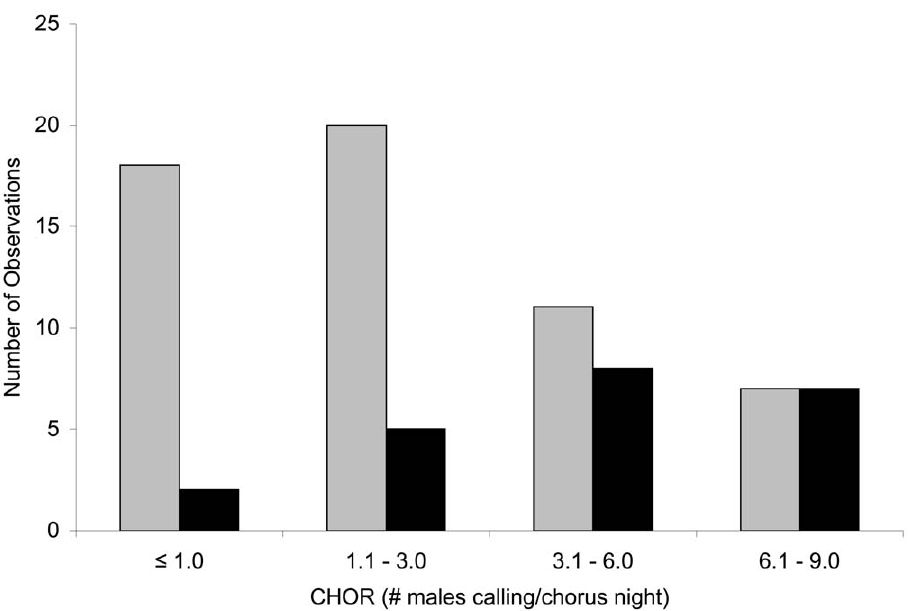
Figure 1. Frequency of observation and reproductive success of four chorus size classes. Mean number of Houston toad ( Bufo houstonensis ) males attending choruses calculated from nights on which at least one male was heard calling (CHOR, grey bars) and number of ponds exhibiting evidence of reproduction (black bars) for four chorus size classes. Proportion of ponds with evidence of reproduction goes up as CHOR increases, with all ponds in the largest size class having evidence for reproduction.